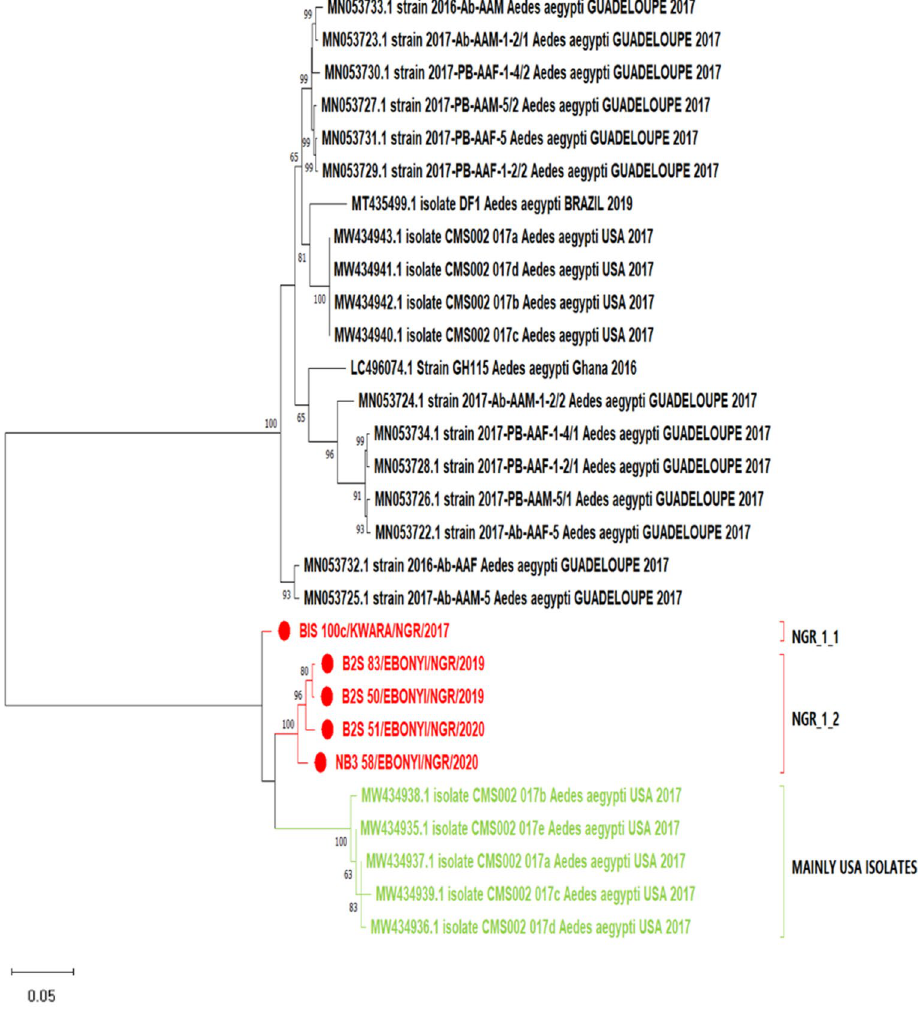
Figure 2. Phylogenetic analysis of orf1 nucleotide sequences of Aedes aegypti totivirus (AaTV). The evolutionary history was inferred using the Maximum Likelihood method and Tamura-Nei model with 1000 bootstrap replicates. The numbers at branch nodes indicate the bootstrap values ≥ 50%. All the reference strains are identified by name and GenBank accession number. Virus strains characterized in this study are highlighted in